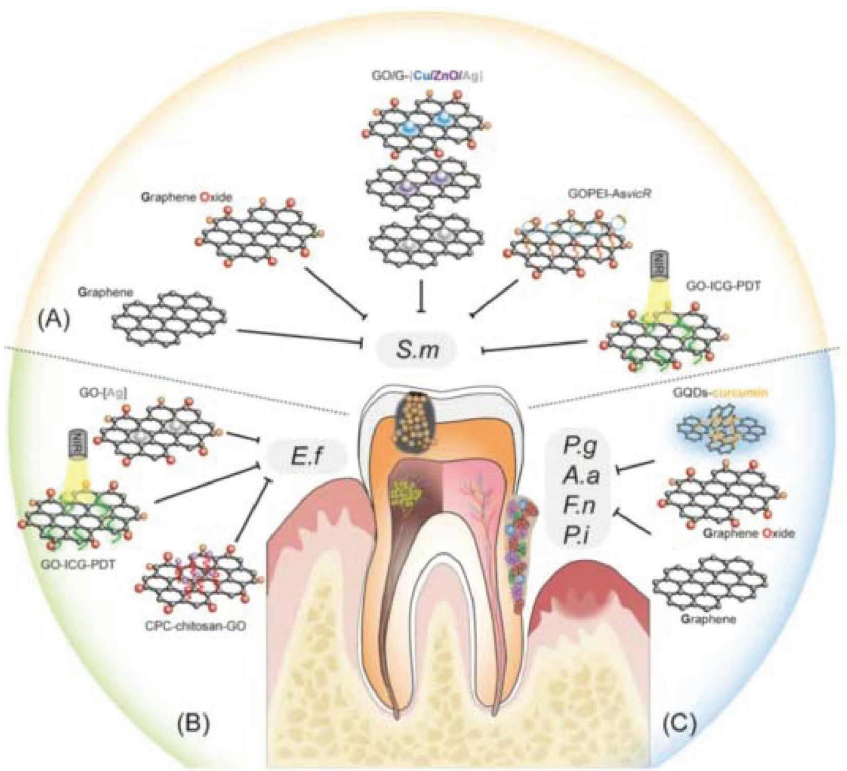
Figure 6: Graphical representation of diferent graphene materials that can inhibit oral bacteria (reprinted with permission from [78]) (Copyright 2015, American Chemical